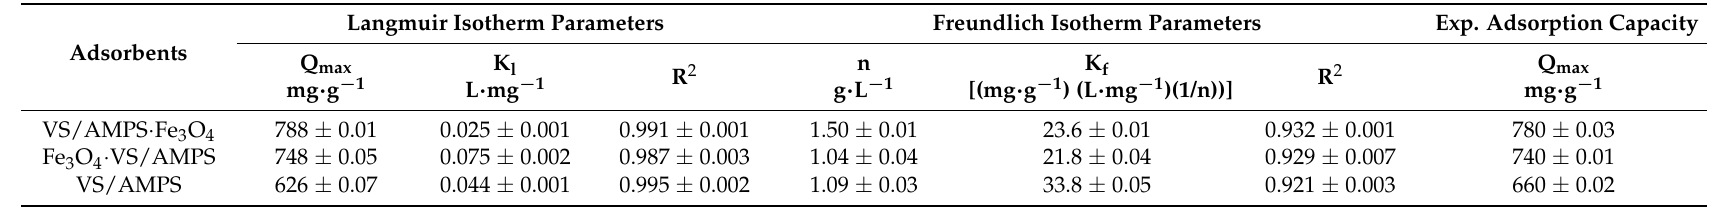
Table 1. Adsorption isotherm parameters of MB dye using VS/AMPS cryogel and its composites at temperature 298 K.